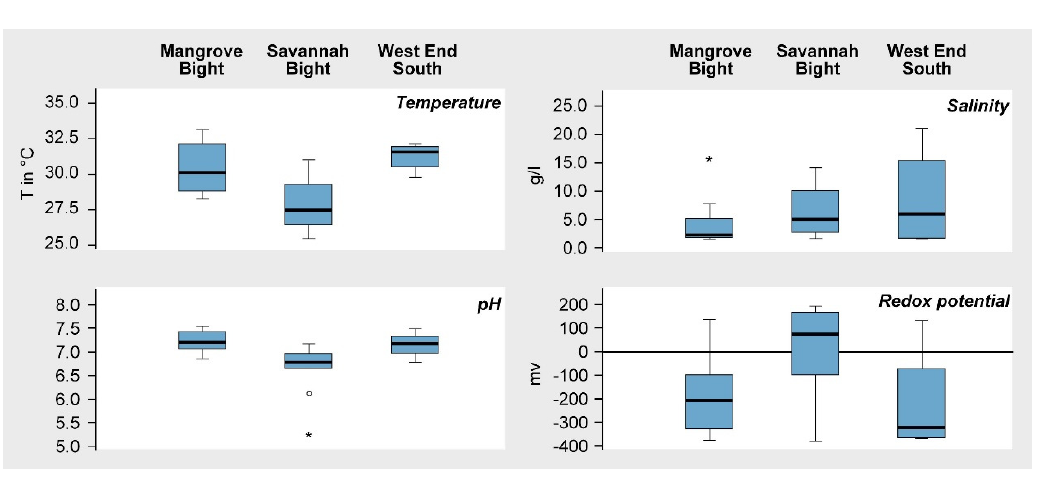
Figure 3. Boxplots of the soil parameters of temperature, pH value, salinity, and redox potential at MB, SB, and WES.